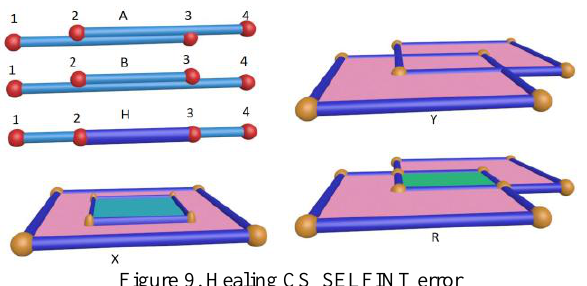
Figure 9. Healing CS_SELFINT error